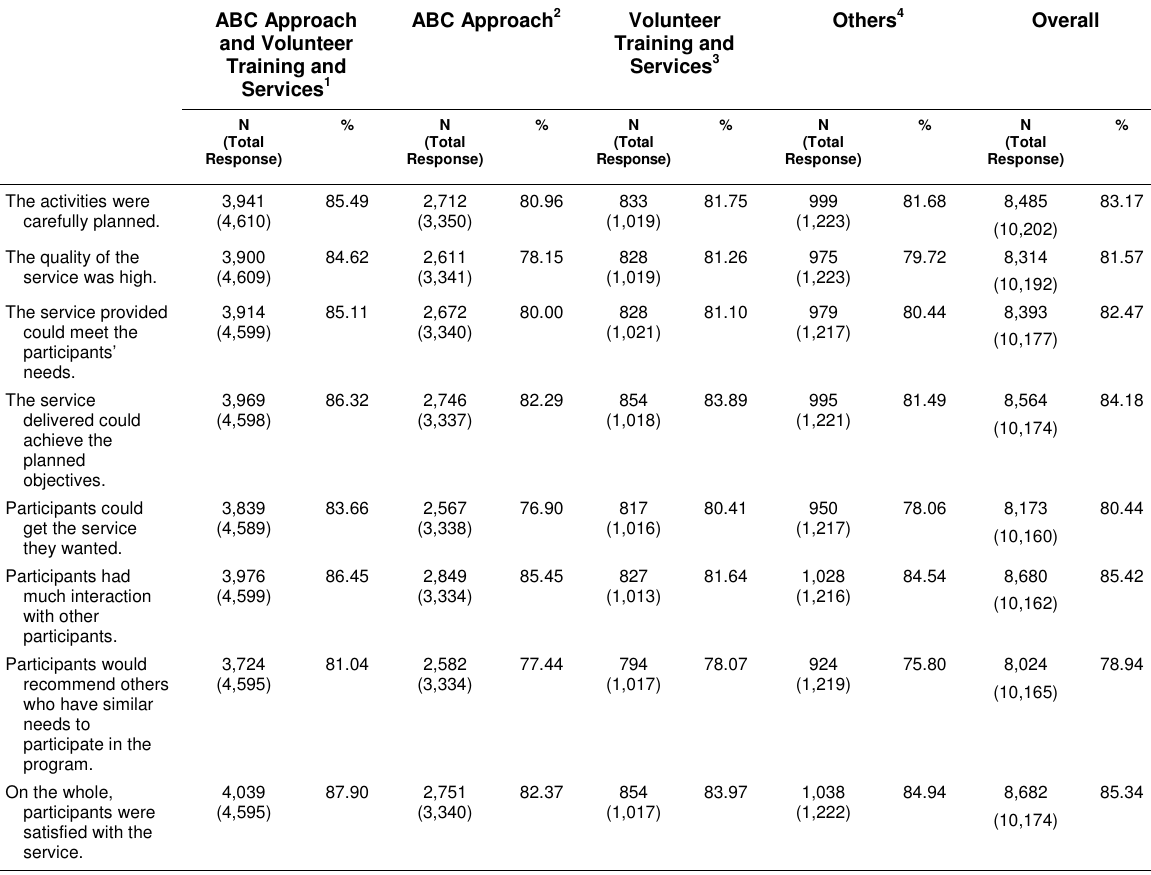
Comparison of the Positive Views Towards the Tier 2 Program Among Different